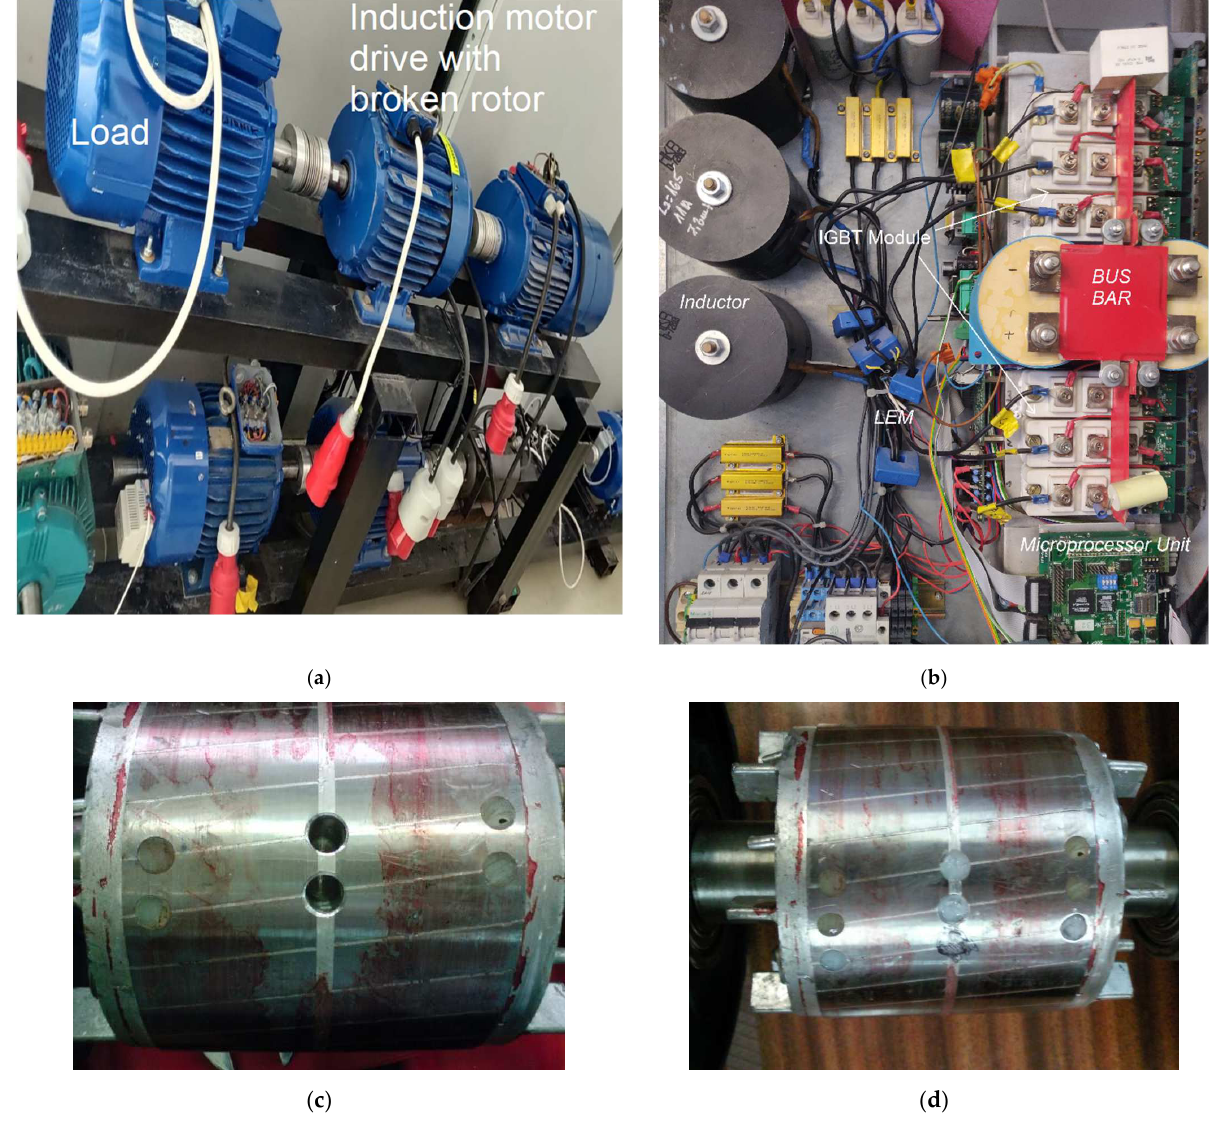
Figure 5. ( a ) Experimental induction motor drive setup with controlled load, ( b ) back-to-back IGBT-based inverter, ( c ) rotor with 2 broken rotor bars, ( d ) rotor with 3 broken rotor